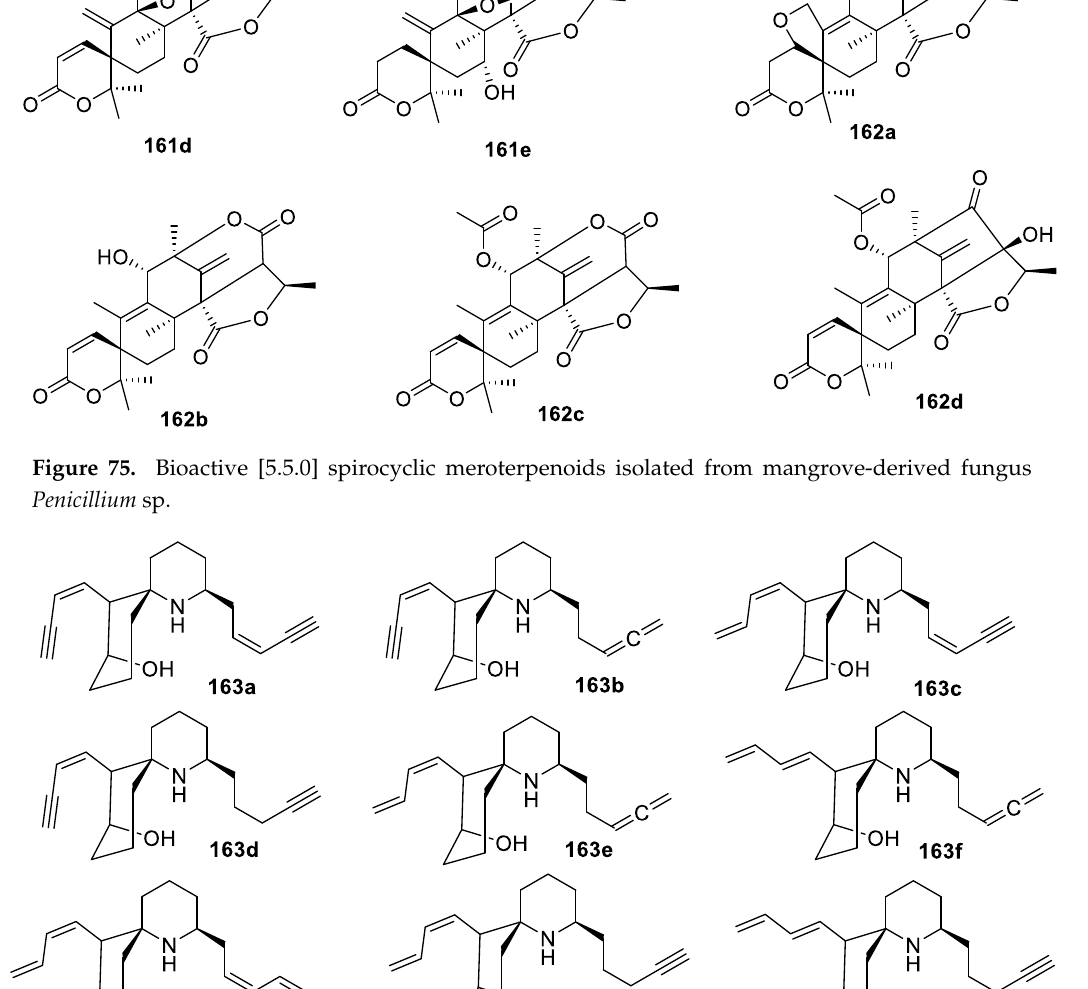
Figure 76. Alkaloids 163 – i of the histrionicotoxin class isolated from ant Carebarella